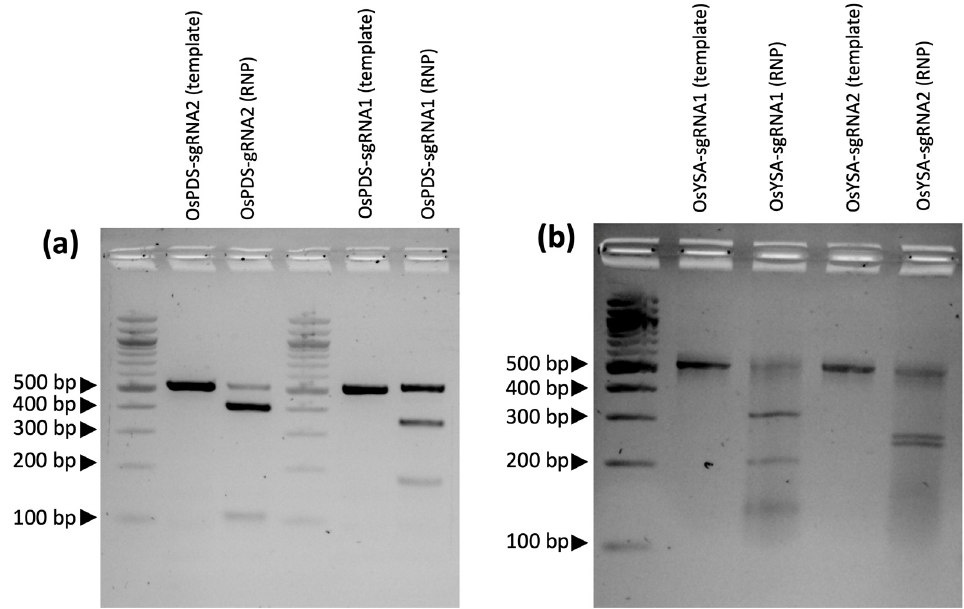
Figure 1. Gel electrophoresis showing in vitro ribonucleoprotein (RNP) assay results with digestion of PCR amplicons using commercial Cas9 with ( a ) PDS gRNAs and ( b ) YSA gRNAs. The gel images show a DNA ladder in lane 1, followed by two reactions for each gRNA: one with the template only, which lacks the gRNA and is uncut, and the second with the functional RNP containing the gRNA showing the PCR amplicons cut into two products, as follows (from left to right): OsPDS-sgRNA2: 515 bp product cleaved into 409 bp and 106 bp fragments; OsPDS-sgRNA1: 515 bp product cleaved into 333 bp and 182 bp fragments; OsYSA-sgRNA1: 526 bp product cleaved into 321 bp and 205 bp fragments; OsYSA-sgRNA2: 526 bp product cleaved into 268 bp and 258 bp fragments.